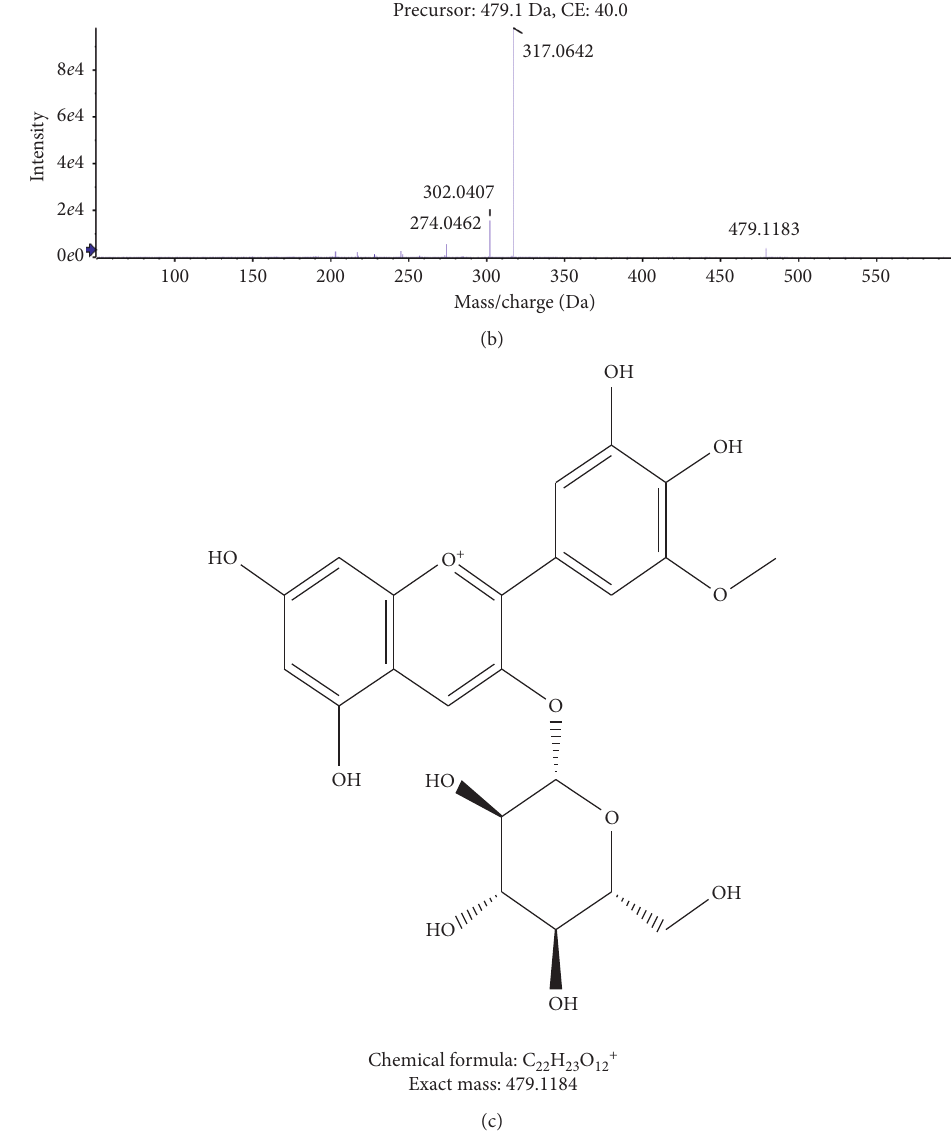
Figure 7: The first class two-level mass spectrogram and the possible structure formula of component